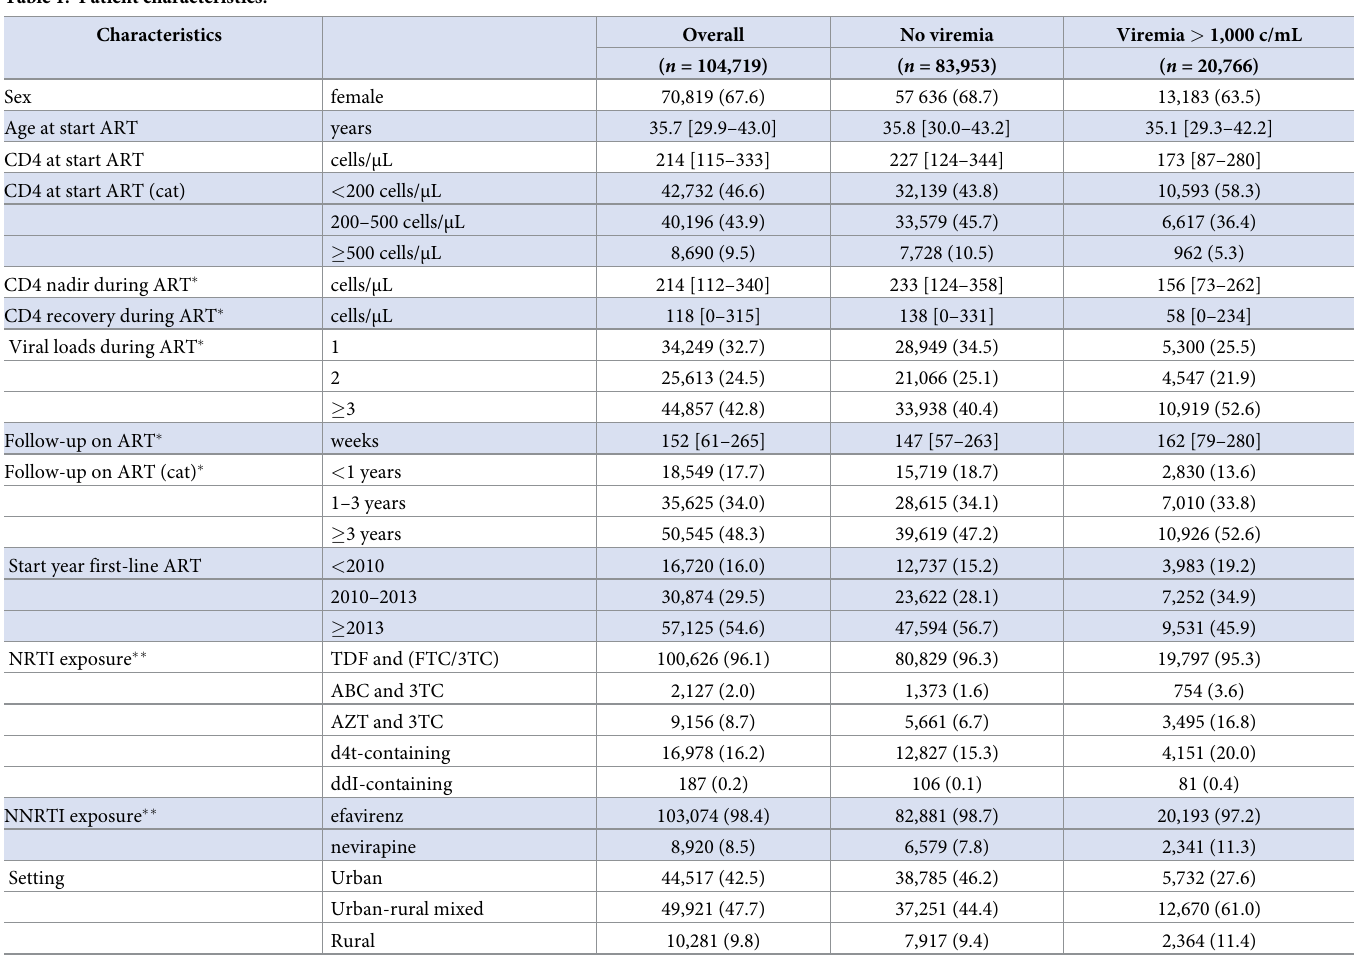
Table 1. Patient